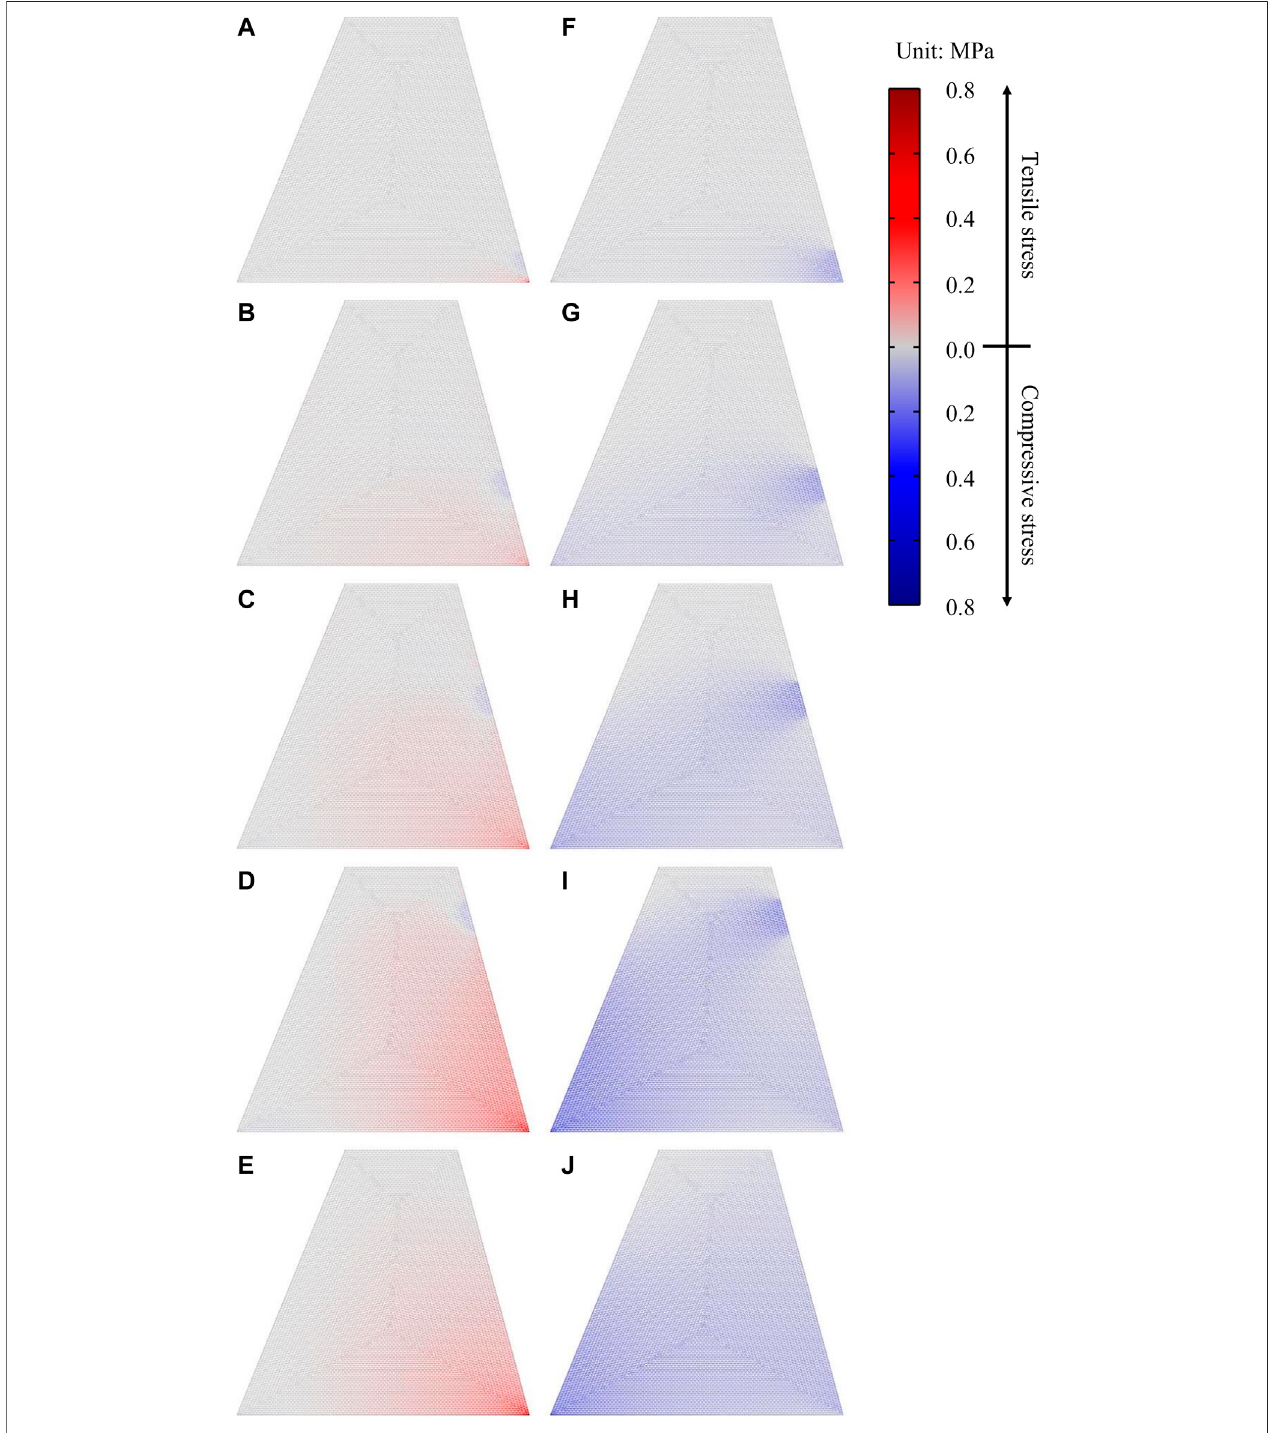
FIGURE 11 | Results of tensile and compressive stress for each deposit scenario. Tensile stress distribution at (A) 0%, (B) 25%, (C) 50%, (D) 75%, and (E) 100% deposition conditions; compressive stress distribution at (F) 0%, (G) 25%, (H) 50%, (I) 75%, and (J) 100% deposition conditions.